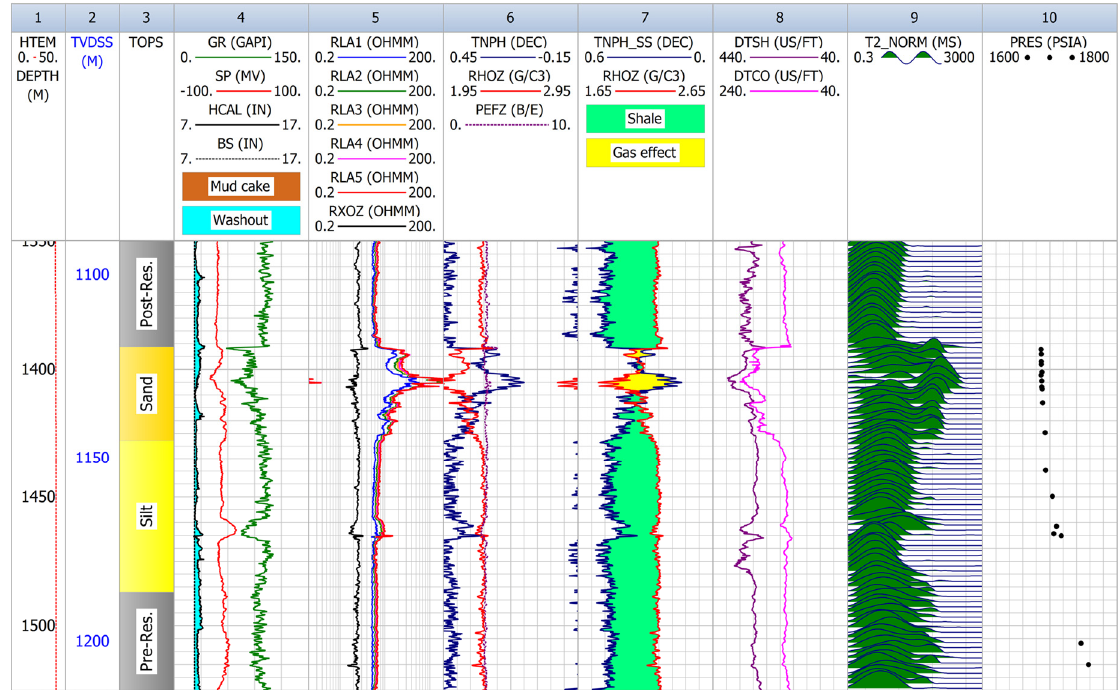
Figure 3. Example of wireline geophysical logs recorded in an exploration well (A-2) from the Early Pliocene gas field “A” (adapted from